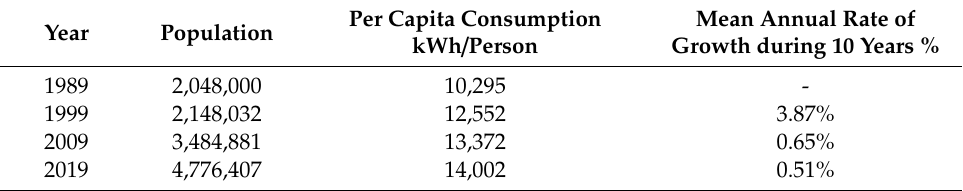
Table 1. The growing population and per capita consumption in three decades